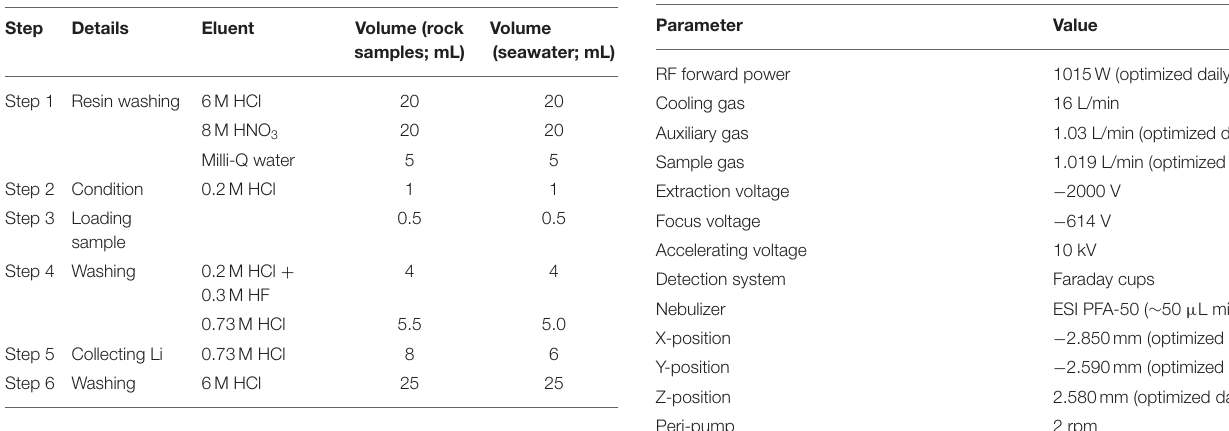
TABLE 1 | Single-column Li separation procedures for rock and seawater samples using AGMP-50 resin.